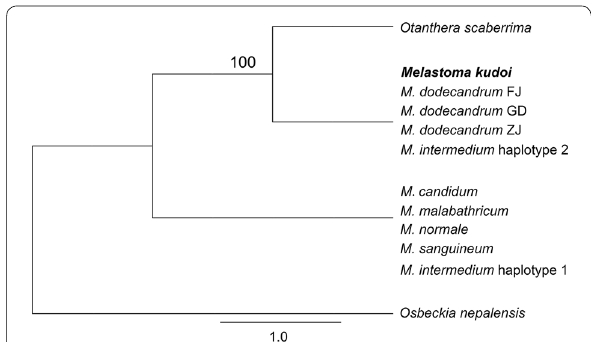
Fig. 3 Maximum likelihood (ML) phylogenetic tree based on the nrITS dataset. Number above branch is bootstrap value obtained from maximum likelihood analysis. FJ, GD and ZJ denote the three sampling localities of M. dodecandrum . For the species with identical ITS sequences, only one sequence was used in the analysis